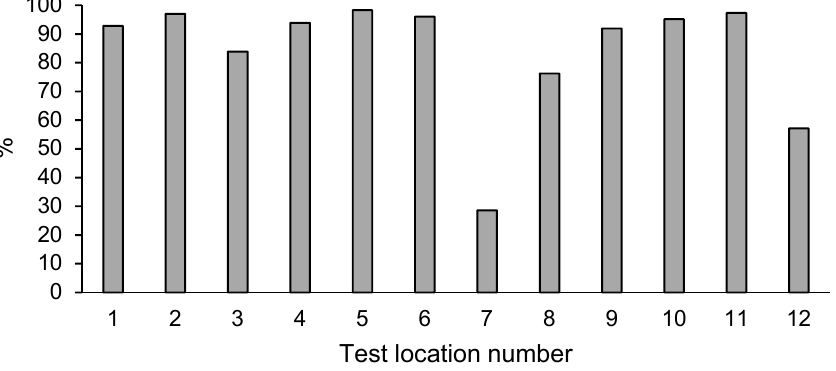
Figure 4. Percentage decrease of total PAH content in the soil after enhanced natural attenuation.